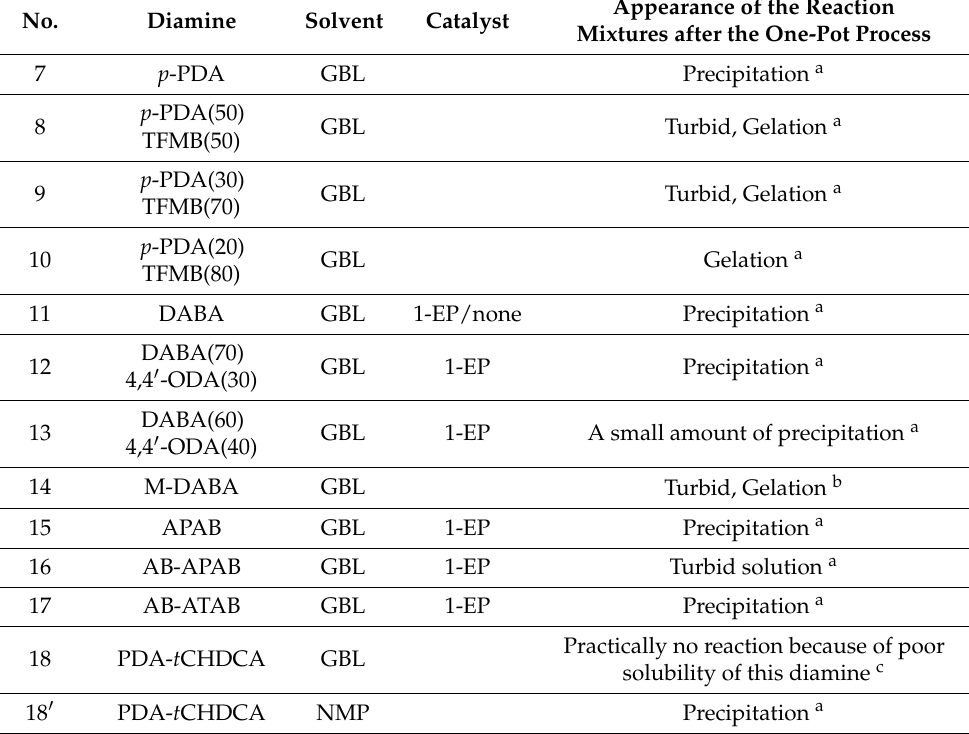
Table 2. The results of one-pot polymerization for the systems comprising H-PMDA and common rigid diamines without substituents. The one-pot reactions were performed at an initial monomer content of 30 wt%, while ensuring effective stirring by appropriate gradual dilution with a minimal requisite amount of the same solvent during the reactions. Appearance of the No. Diamine Solvent Catalyst